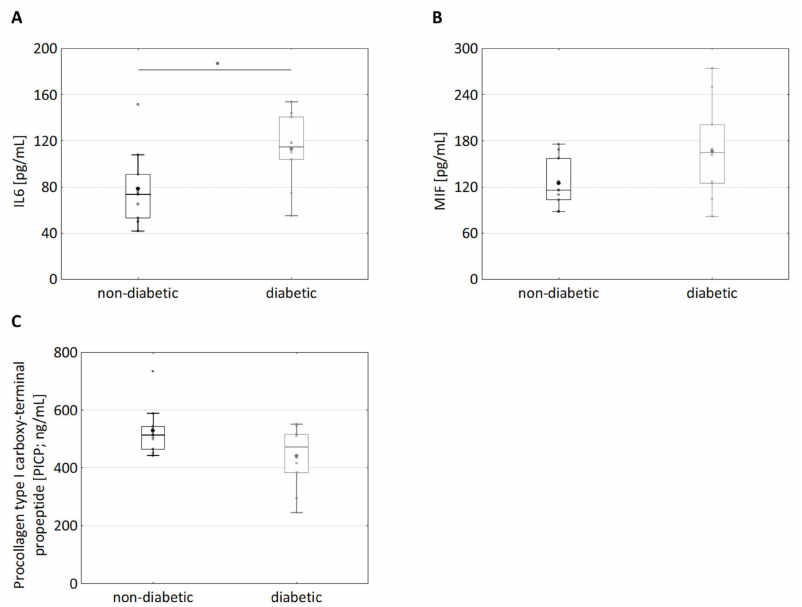
Figure 2. Difference in secretion of IL-6, macrophage migration inhibitory factor and Procollagen Type I C-Peptide in dermal fibroblasts from diabetic and non-diabetic donors. ( A ) The supernatants of cultured fibroblasts from diabetic and non-diabetic donors were analysed for IL6 levels using Homogeneous Time Resolved Fluorescence assay; n non-diabetic = 10; n diabetic = 10, * p < 0.05. ( B ) The supernatants of cultured fibroblasts from diabetic and non-diabetic donors were analysed for MIF using ELISA; n non-diabetic = 10; n diabetic = 10. ( C ) The supernatants of cultured fibroblasts from diabetic and non-diabetic donors were analysed for procollagen type I C-peptide using ELISA. Statistical significance was determined